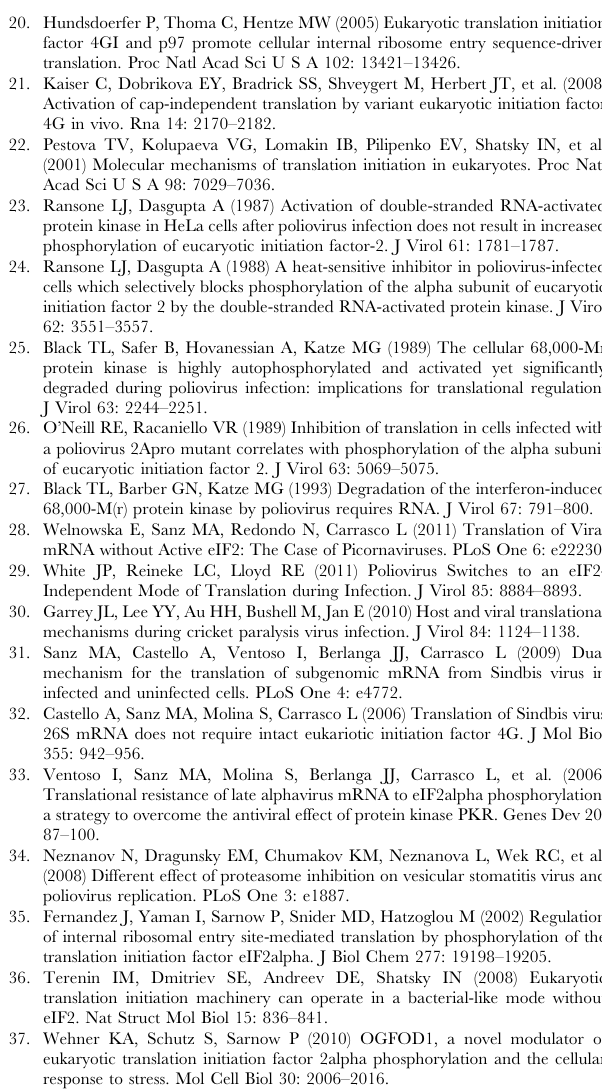
Figure S3 Effect of 2A pro on PKR. BHKT7 cells were mock- or transfected with pTM1-2A in presence or absence of Ars. Protein kinase RNA-activated (PKR) was detected by western